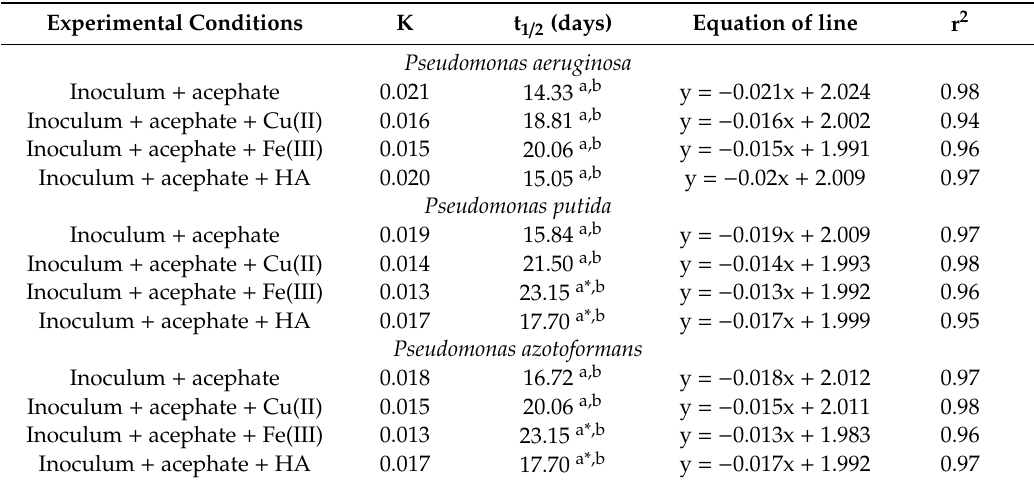
Table 2. Kinetics of biodegradation of acephate by three bacterial strains in M9 medium. Experimental